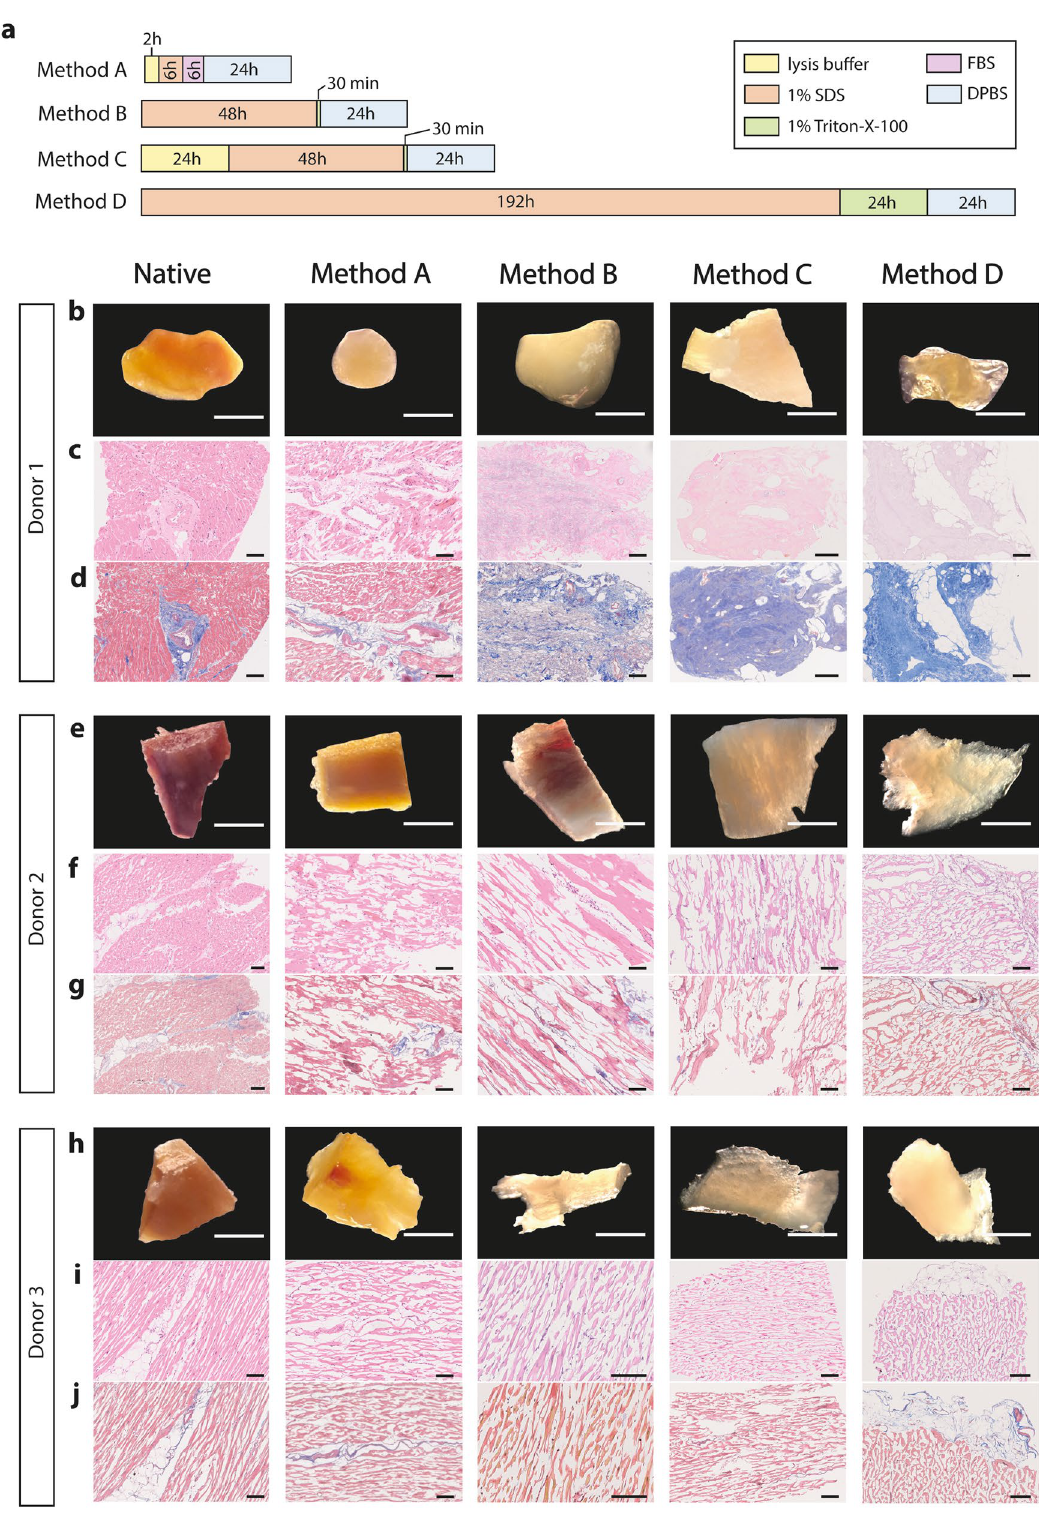
Figure 1. Histological assessment of the different chemical-based decellularization methods attempted for human cardiac tissue. ( a ) Chemical-based decellularization methods tested for human cardiac tissue. The details regarding the solutions used and exposure duration applied are highlighted for each decellularization step. For each donor is shown: ( b ), ( e ), ( h ) Gross tissue morphology. Scale bars: 1 mm; ( c ), ( f ), ( i ) Hematoxylin & Eosin staining. Scale bars: 100 µm; ( d ), ( g ), ( j ) Masson’s Trichome staining. Scale bars: 100